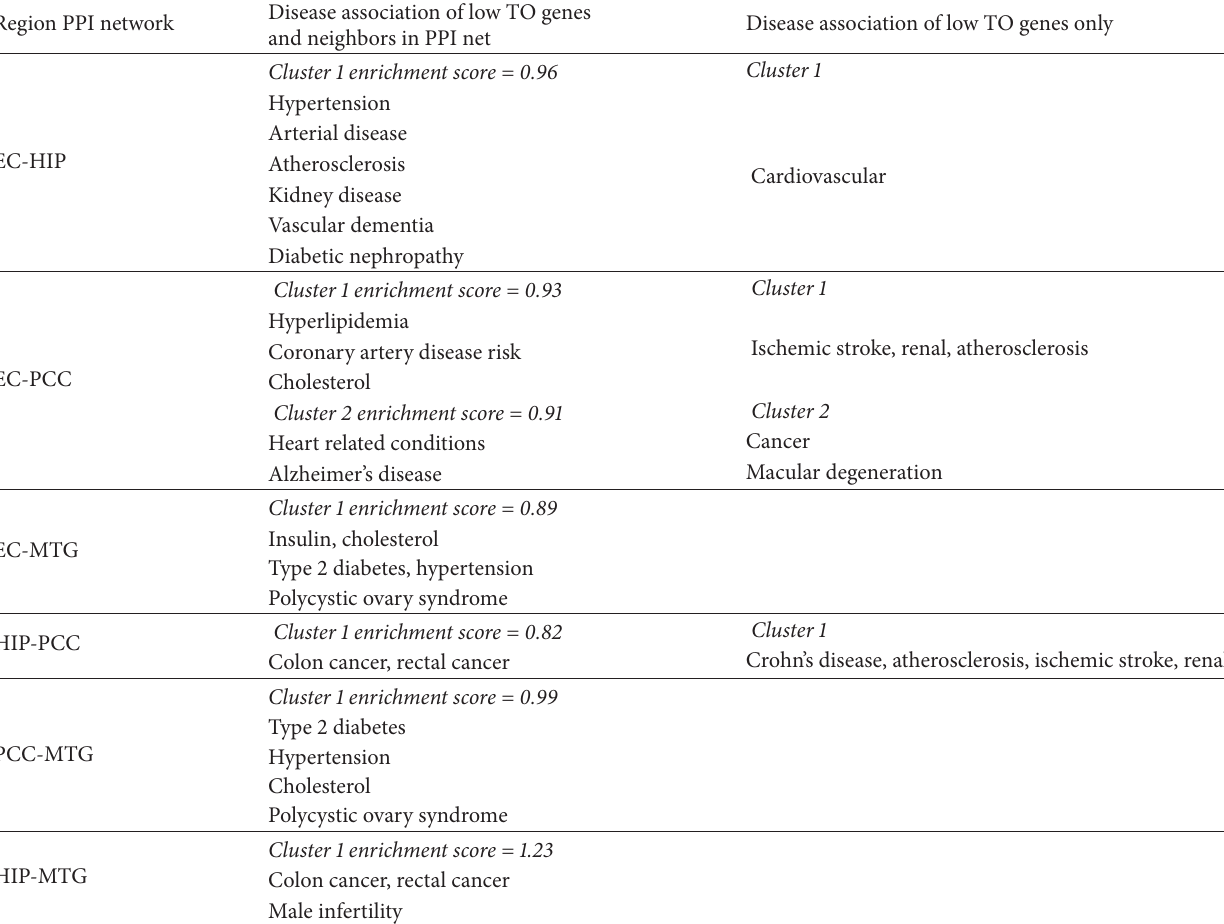
Table 4:DiseaseassociationsofsetsoflowTOgenes with(extended set)andwithout (primaryset)theirdirectneighbors inthePPInetworks. Region PPI